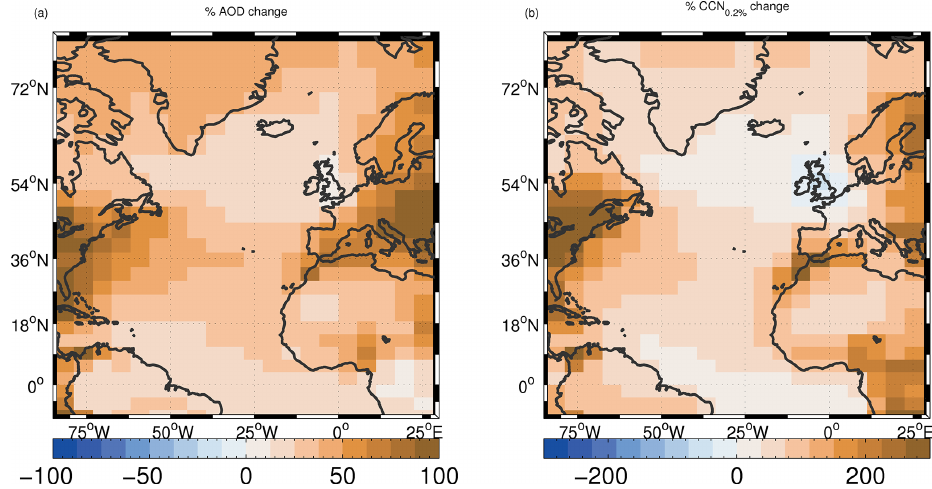
Figure C2. Mean percentage increase (between PI and PD model runs) in (a) 550nm AOD and (b) CCN at 0.2% supersaturation using aerosol from the lowest model layer.